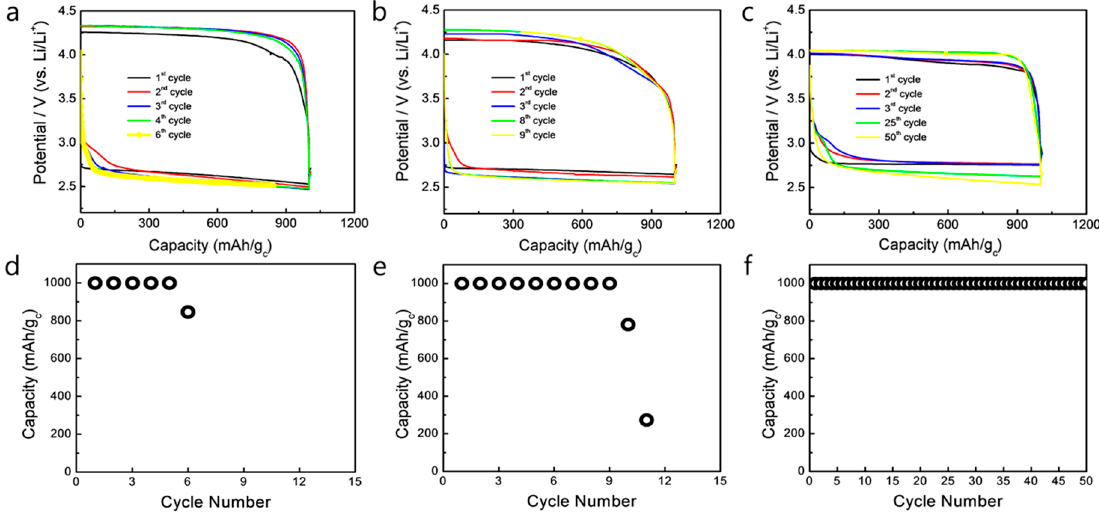
Figure 3. Electrochmical properties of CNF electrodes. Voltage profiles of ( a ) CNF 1000, ( b ) CNF 1200